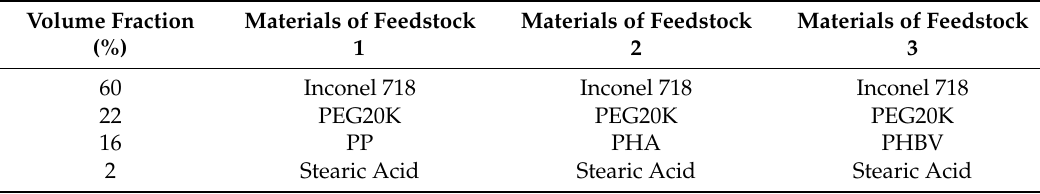
Table 2. Composition of the formulations.